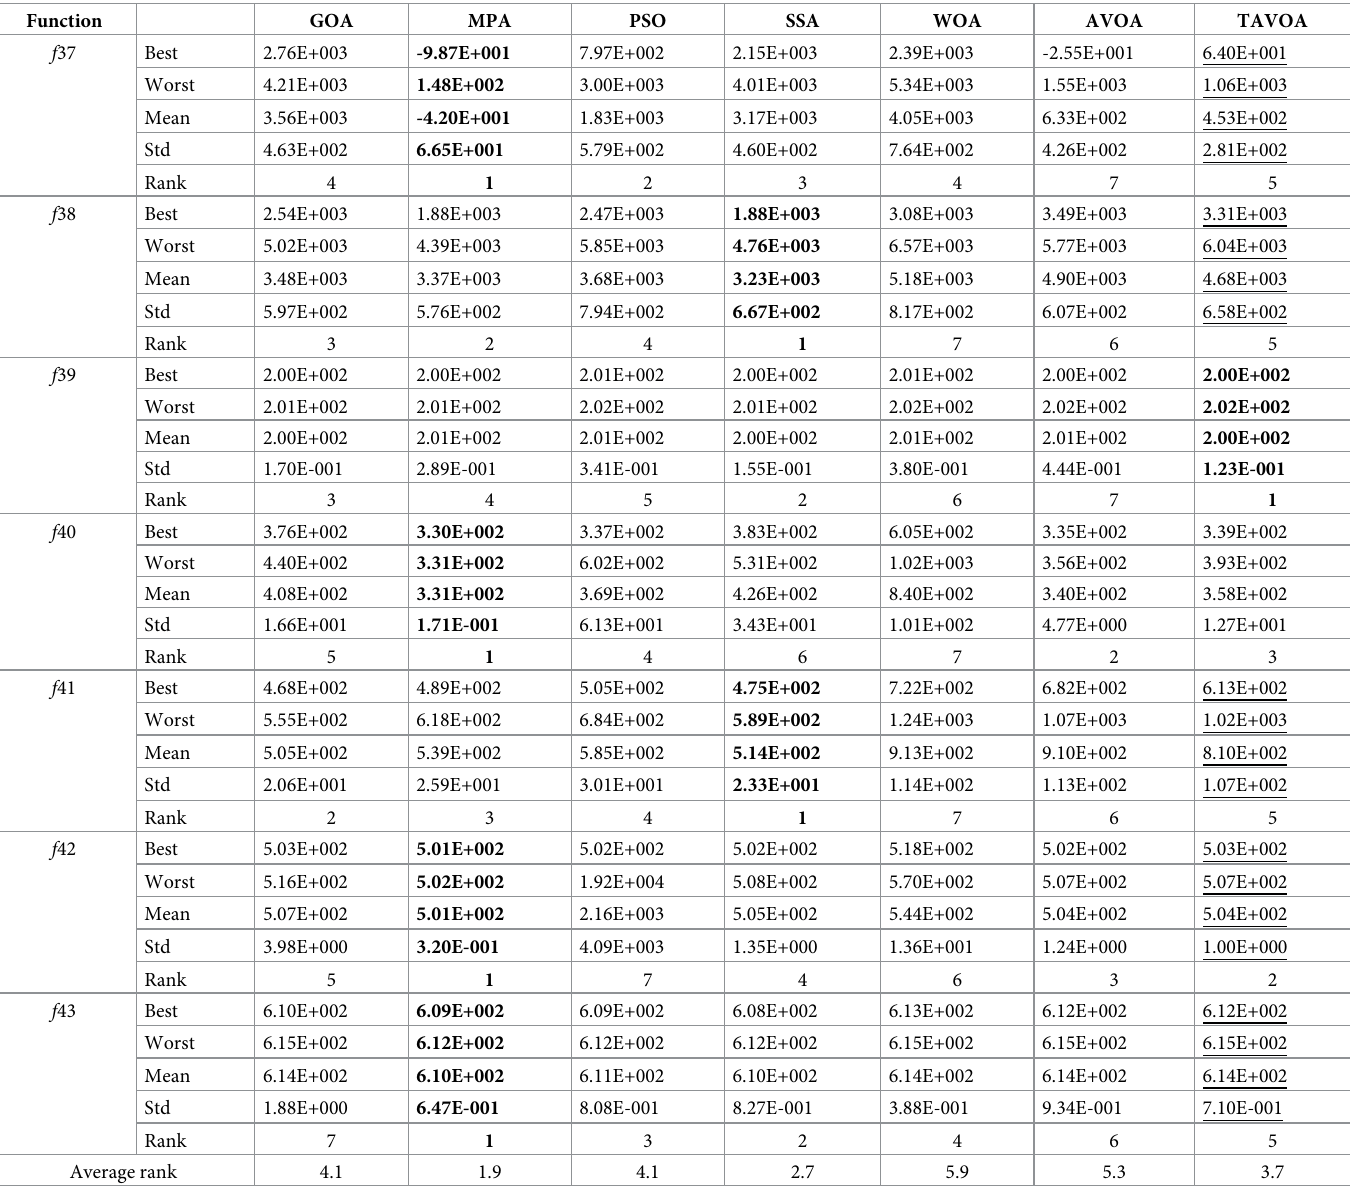
Table 9. Experimental results of CEC 2013 basic multimodal benchmark functions ( f 37 − f 43).